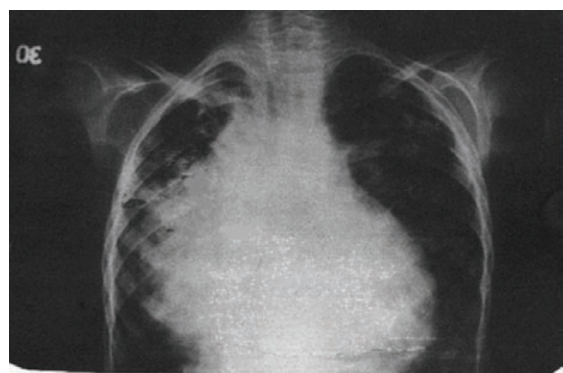
Figure 1. Cardiomegally and wide pulmonary infiltretion in patient’s chest X-Ray at antero-posterior position.